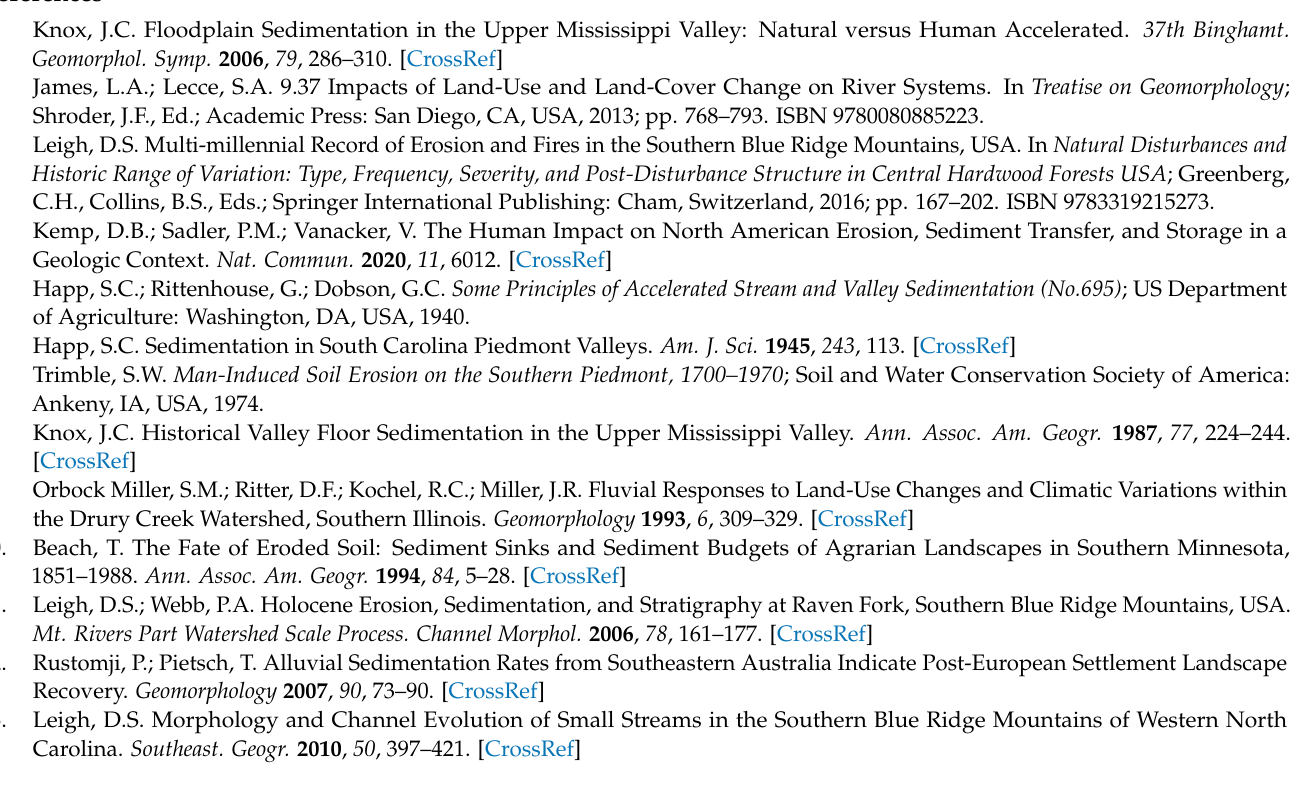
Table S2: Summary of dendrochronologic data; Table S3: Summary of radiocarbon samples and dates; Figure S3: Photographs of exposed tree roots caused by bank erosion and used to deter- mine bank erosion rates; Figure S4: Schematic diagram of aggradational-degradational episode; Figure S5: Photography of inactive gully; Figure S6: Photographic of typically bedrock channel reach; Figure S7: Classic Channel Evolution Model; Figure S8: Contrasting Erosion between Precolonial and Legacy